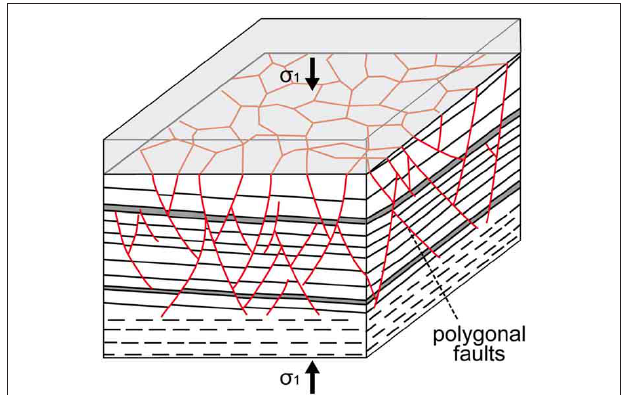
FIGURE 1 | Conceptual sketch of polygonal faults in a sedimentary basin (modified from and inspired by Cartwright, 1994b; Cosgrove, 1998). Note that this particular type of normal faults forms polygonal meshes over horizontal cross-sections and are vertically restricted to particular stratigraphic intervals (or tiers) of sedimentary basins. Polygonal faults are thought as being diagenetic non-tectonic structures (Cartwright,